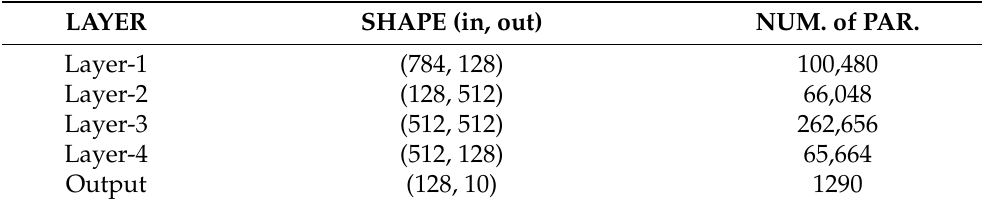
Table A3. Model Architecture for MNIST-digits, MNIST-fashion and EMNIST-letters classifications used in the test for the dependence of model performance on data domain for different linearity factors ( α ) (Figure 3, right panel). Categorical Cross-entropy loss was used for the loss estimation. Stochastic Gradient Descent (SGD) with learning rate = 0.1 was used as the optimizer.